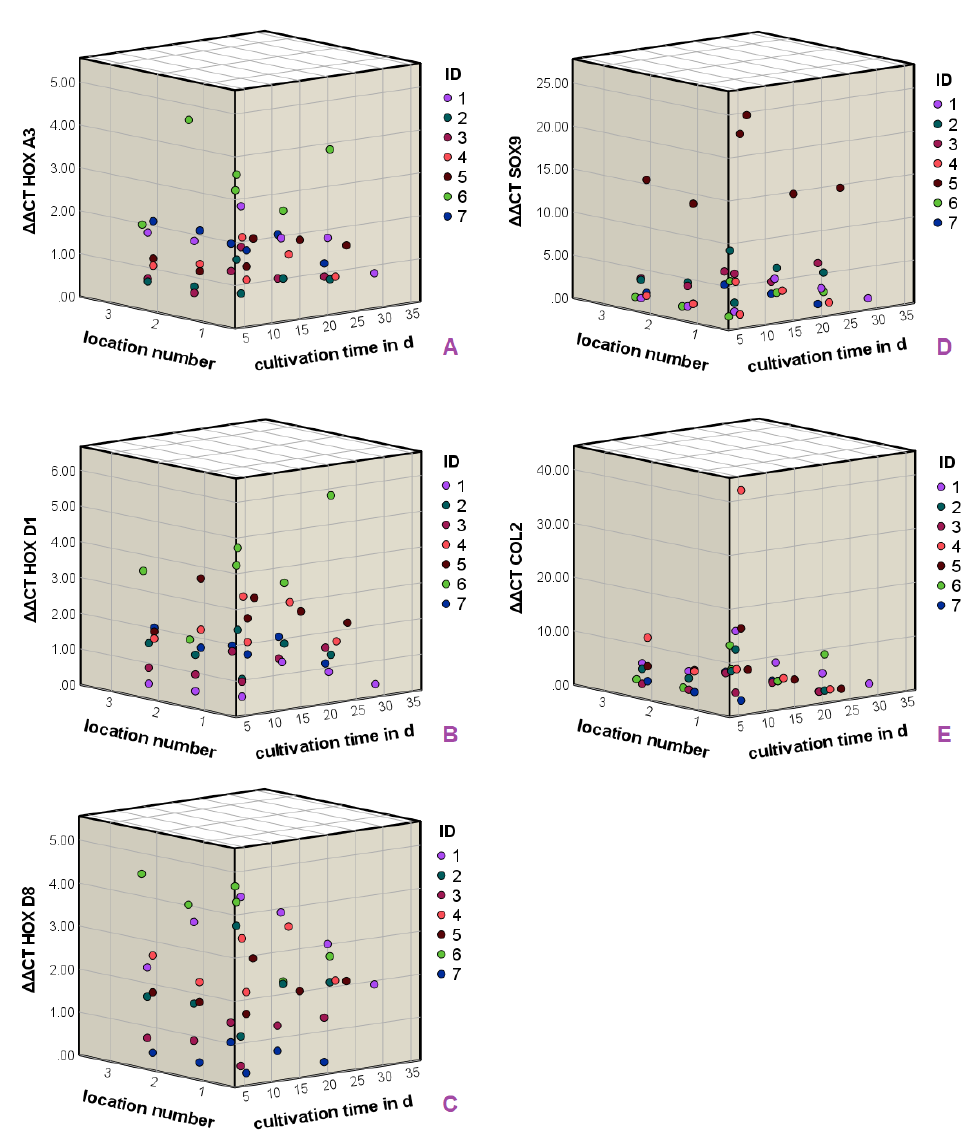
Figure A2. Individual expression levels of HOX genes A3 ( A ), D1 ( B ), D8 ( C ) and the tissue- identifying genes SOX9 ( D ) and COL2 ( E ) in the three locations: 1 = nose, 2 front fetlock, 3 = hind fetlock. ( A – C ) The different quantities of mRNA of the HOX genes showed individual levels, without a noticeable dependence of cultivation time or location. ( D ) In SOX9, the only adult male horse not neutered showed a high expression level, whereas the levels of the other individuals were markedly lower. ∆∆ CT value of SOX9 does not seem to be correlated to cultivation time or location. ( E ) COL2 shows wider spreading of nasal mRNA levels than articular mRNA levels during early cultivation. All COL2 ∆∆ CT values are close to zero in late cultivation. Individual levels are hardly noticeable in